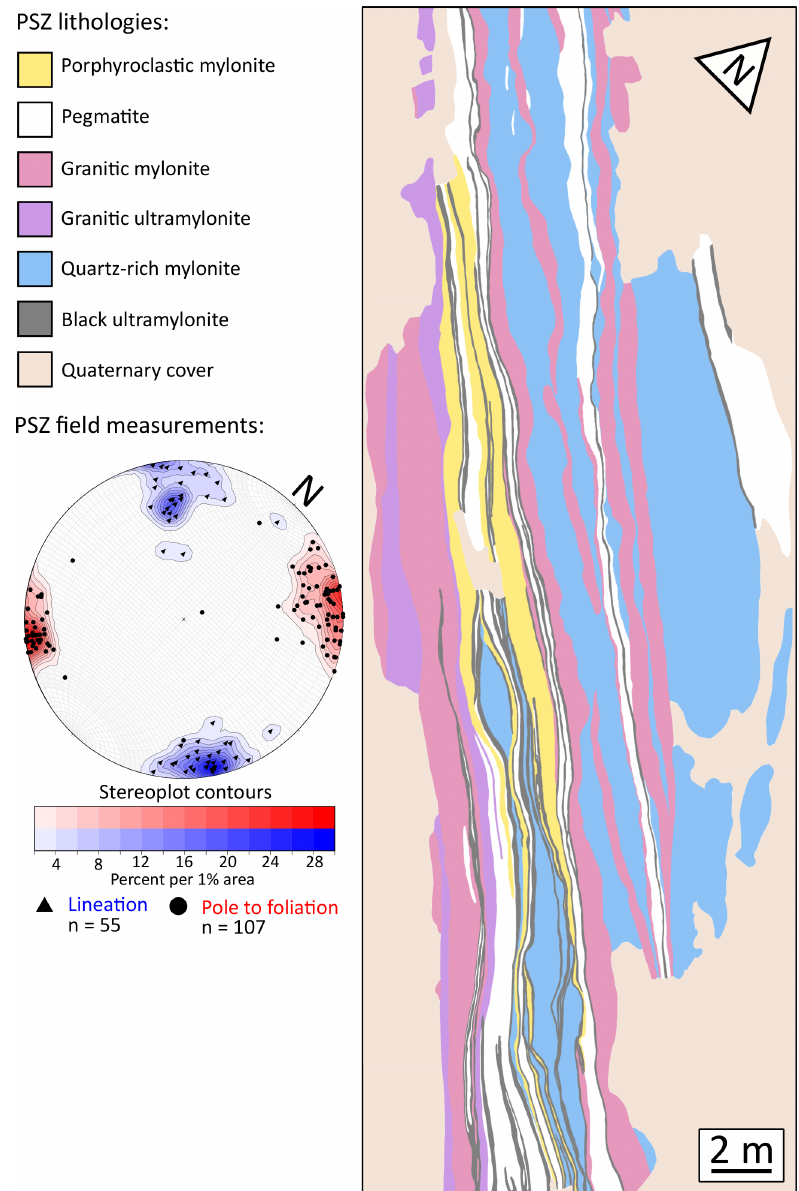
Figure 2. Map of the Coboop Island fault core showing major mylonite units and Quaternary cover. Stereonet is rotated to match the orientation of the map and contains contoured measurements of poles to foliation (circles) and lineations (triangles). High-resolution basemap and map structural measurements are included as a